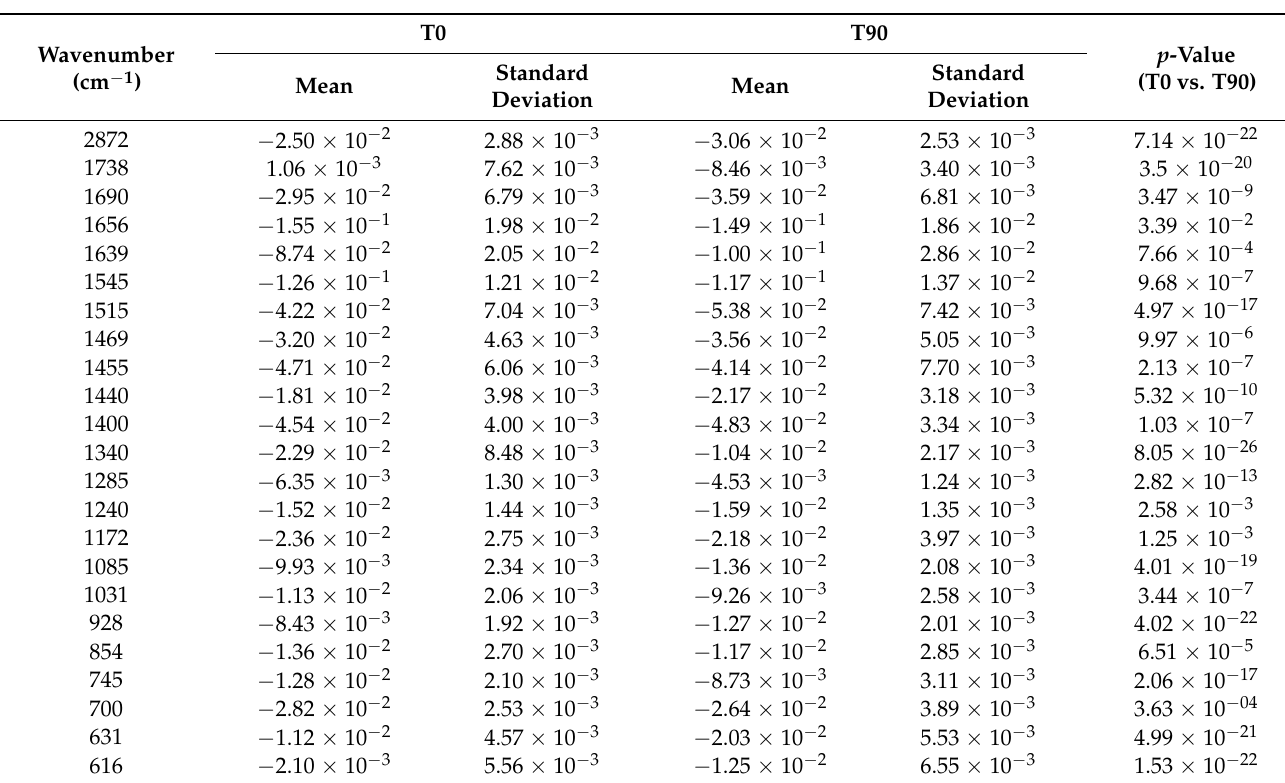
Table 2. Mean values and standard deviations of negative bands of the normalized second derivative spectra of plasma at T0 and T90, respectively, and p -value of Student’s t -test regarding the comparison between T0 and T90, at p <